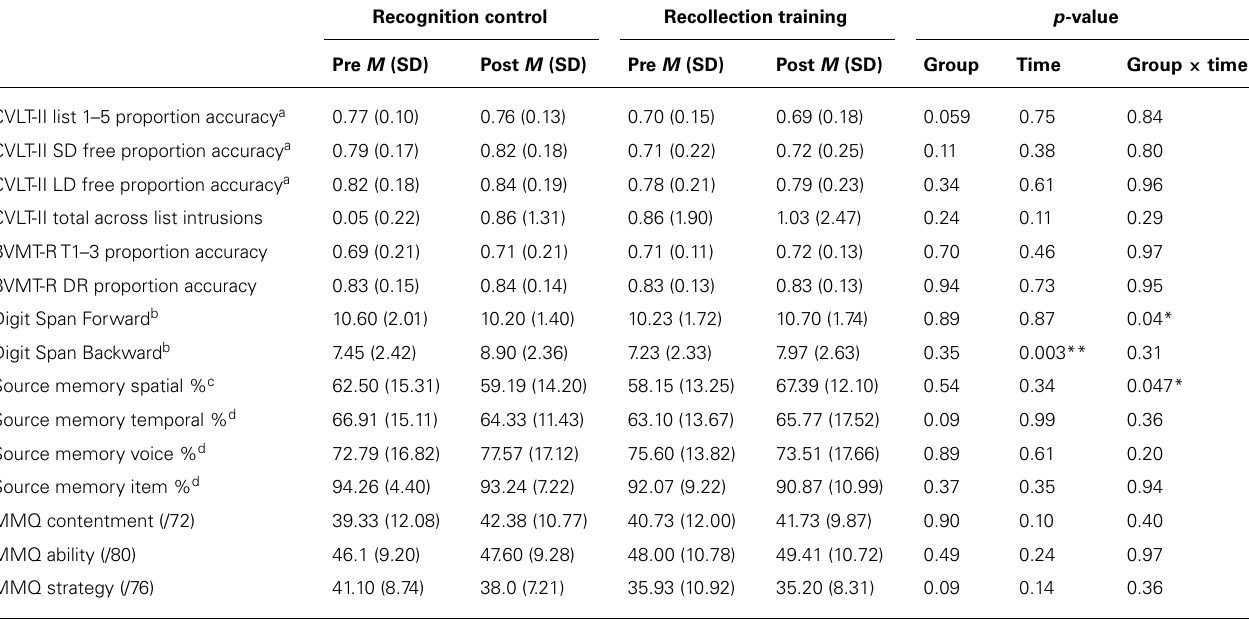
Table 3 | Pre- and post- training scores on transfer